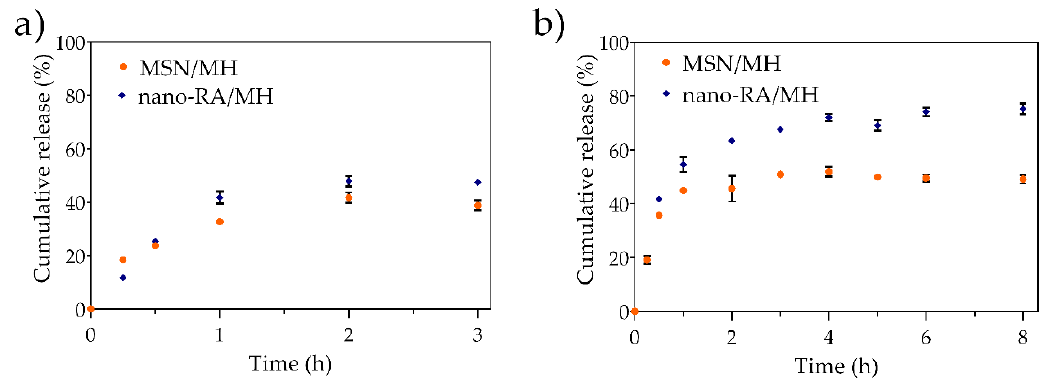
Figure 6. In vitro release profile of morin loaded in MSN (MSN/MH) and nano-RA (nano-RA/MH), in ( a ) simulated gastric fluid and ( b ) simulated intestinal fluid, at 37 °C.